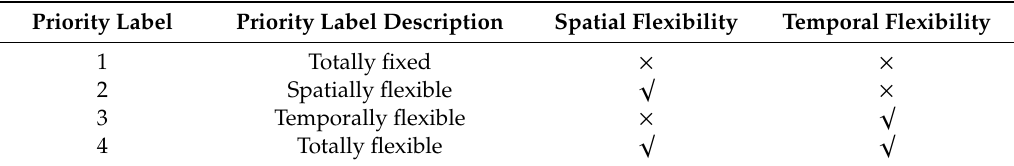
Table 5. Priorities of the travelers